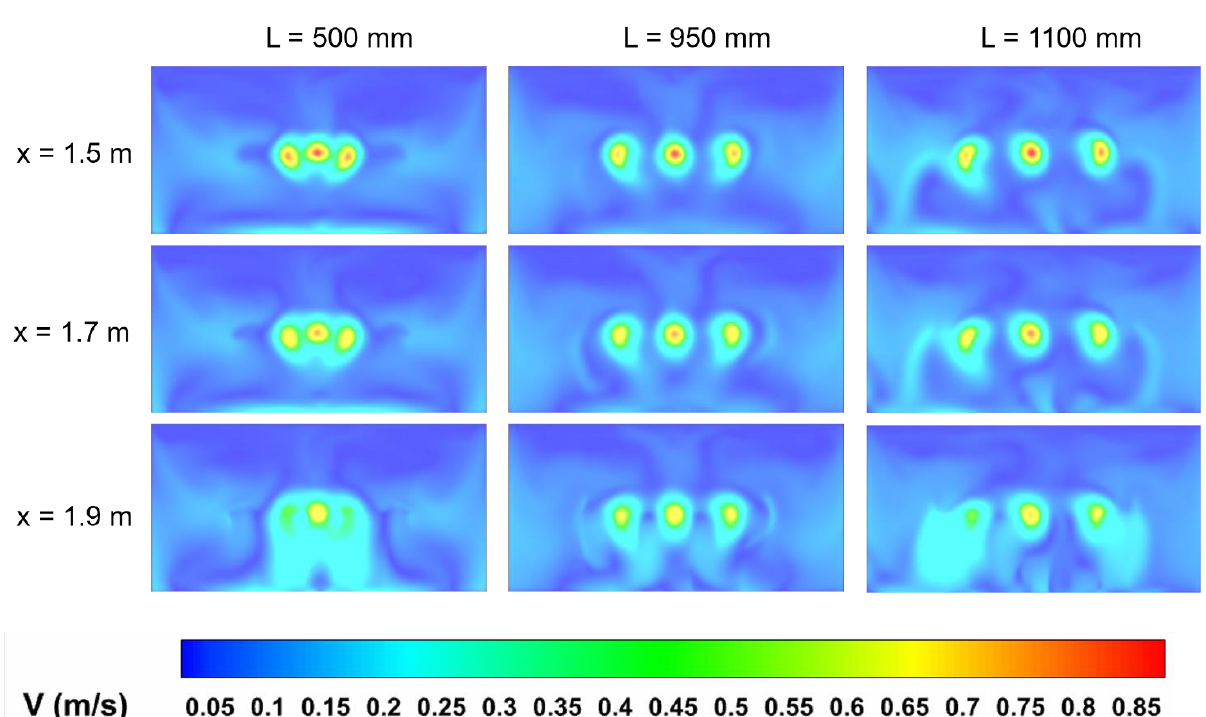
Figure 10. Velocity distribution contour for x = 1.5 m, 1.7 m, and 1.9 m for three air inlet spacings.